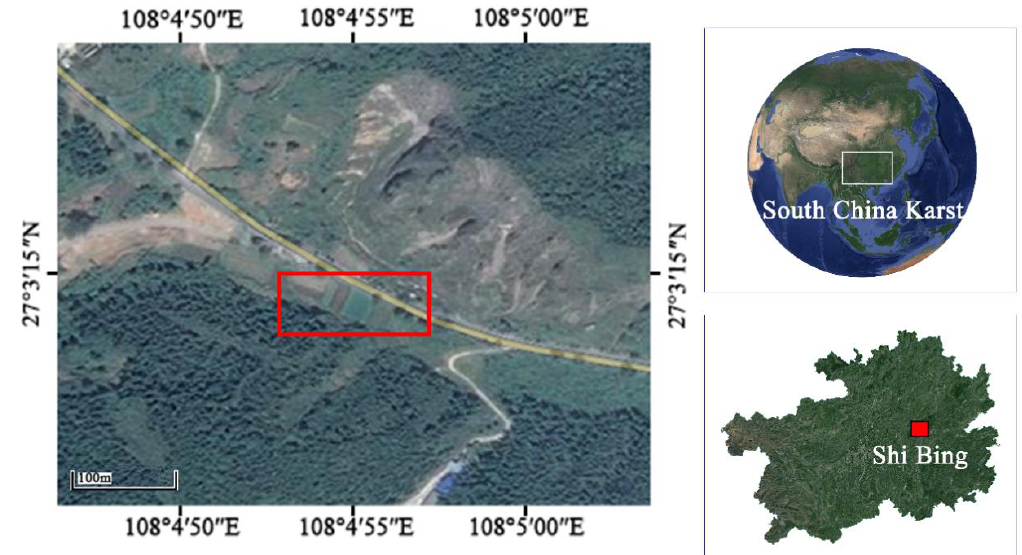
Figure 1. Study area and sample location information.